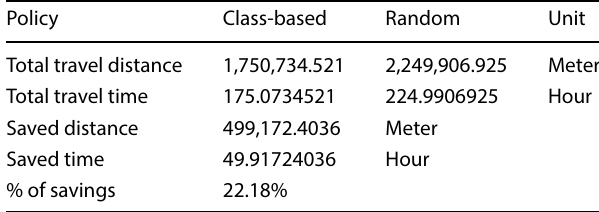
Table 7 Results of the performance comparisons (class-based pol- icy vs random